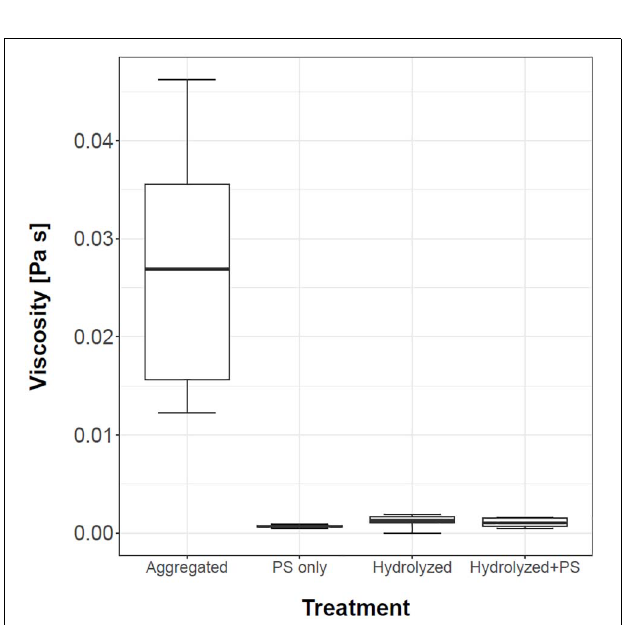
FIGURE 8 | Viscosity of mucus, PS microspheres suspension, hydrolyzed mucus and hydrolyzed mucus with PS microspheres is presented with the box and whiskers plots. Three replicates were used for measuring the PS microspheres suspension (control), while n = 5 was used for the rest of the treatments.